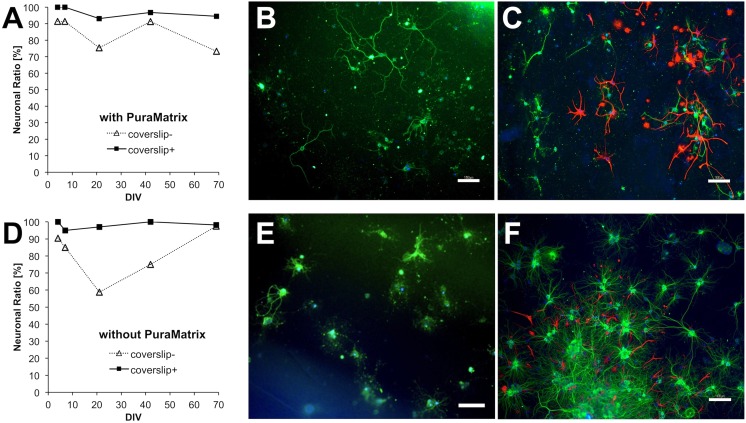
Effect of the coverslip and PuraMatrix on the neuronal ratio of primary neurons.Bars: 100 µm. Neurons from E18 rat hippocampi were plated at 3×104 cells/mL in basic medium #0 and coverslipped 3 h after plating (+), or not (−). Before plating, 25% PuraMatrix was already prepared in a well (A–C) or the wells were not treated (D–F). The neurons attached to PuraMatrix (A–C) or the polystyrene, tissue culture-treated bottom (D–F) and grew. The neurons were plated into five multiplates simultaneously, and the neuronal ratio in each plate was only examined once at DIV 4, 7, 21, 42, or 69. Neurons and astrocytes were double-stained with anti-MAP2 for neurons (green) and anti-GFAP for astrocytes (red), with DAPI as a nuclear counterstain (blue). Neurons and astrocytes were counted in six areas in each well: three areas in the center and three areas at the edge, and their total numbers were used for analysis. The neuronal ratio was consistently higher in the coverslip+ compared with the coverslip– condition at DIV 4–69 (A, D). (A) Our combined sandwich culture technique using both a coverslip and PuraMatrix (coverslip+) achieved a high neuronal ratio of nearly 100%. Fluorescence images at DIV 42 at the edge of the coverslip+ (B) and coverslip− (C) wells. (B) Neurons (green) preceded astrocytes (red). (C) Astrocytes proliferated locally, mainly at the edge of the well. (D) Sandwich culture using coverslip only (coverslip+) also yielded a high neuronal ratio of nearly 100%. Fluorescence images at DIV 42 at the edge of the coverslip+ (E) and in the center of the coverslip− (F) wells. (E) Neurons (green) preceded astrocytes (red). The image is unfocused because of the influence of intrinsic fluorescence of the polystyrene well itself, especially at the edge. (F) Astrocytes proliferated locally, mainly in the center of the well, where many cells aggregated.